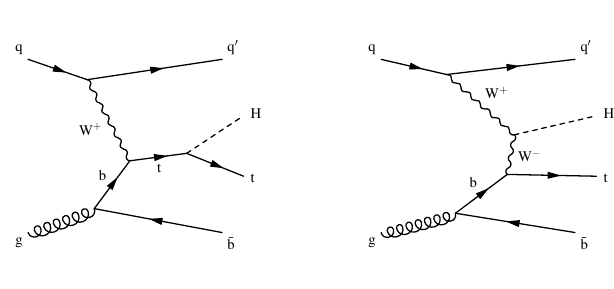
Figure 2. Feynman diagrams of the leading order signal